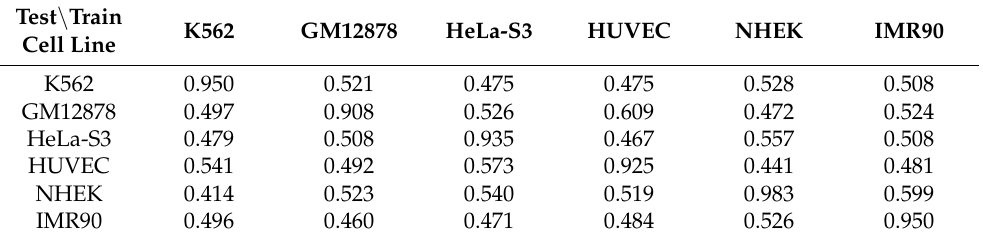
Table 2. AUC (area under the curve) value of cell line-specific model in different cell lines.